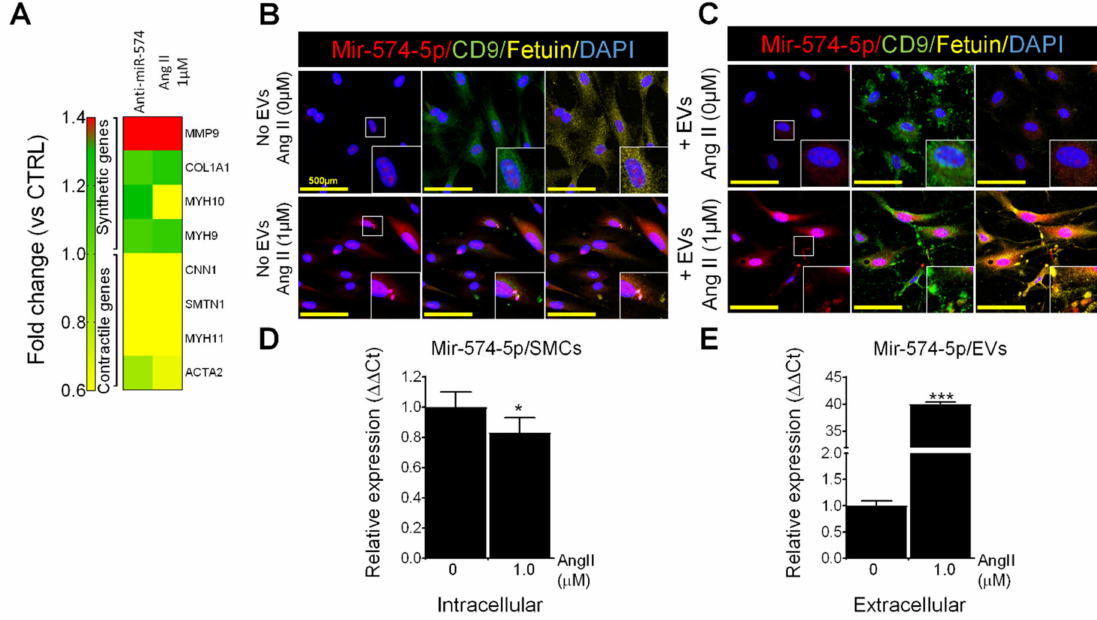
Figure 5. E ff ect of angiotensin II (Ang II) on miR-574-5p expression and EV secretion in human primary vascular smooth cells (VSMCs). ( A ) Relative expression of genes associated with synthetic or contractile phenotype measured by PCR in human VSMCs treated with anti-miR-574-5p or with Ang II (1 µ M). ( B ) VSMCs treated or not with 1 µ M of Ang II. ( C ) VSMCs treated with EV from normal VSMC or from VSMCs treated with 1 µ M of Ang II. ( D ) Relative expression of miR-574-5p measured using PCR in VSMCs treated or not with Ang II. ( E ) Relative expression of miR-574-5p measured using PCR in EVs secreted by VSMCs treated or not with Ang II. Immunofluorescence and FISH staining of miR-574-5p (red); CD9, a membrane marker of EVs (green); fetuin, a marker of EV secreted from VSMC (yellow) and nucleus (blue) were used on primary human VSMCs. The yellow bar corresponds to 500 µ m. Cells originate from an adult men. * p < 0.05; *** p <